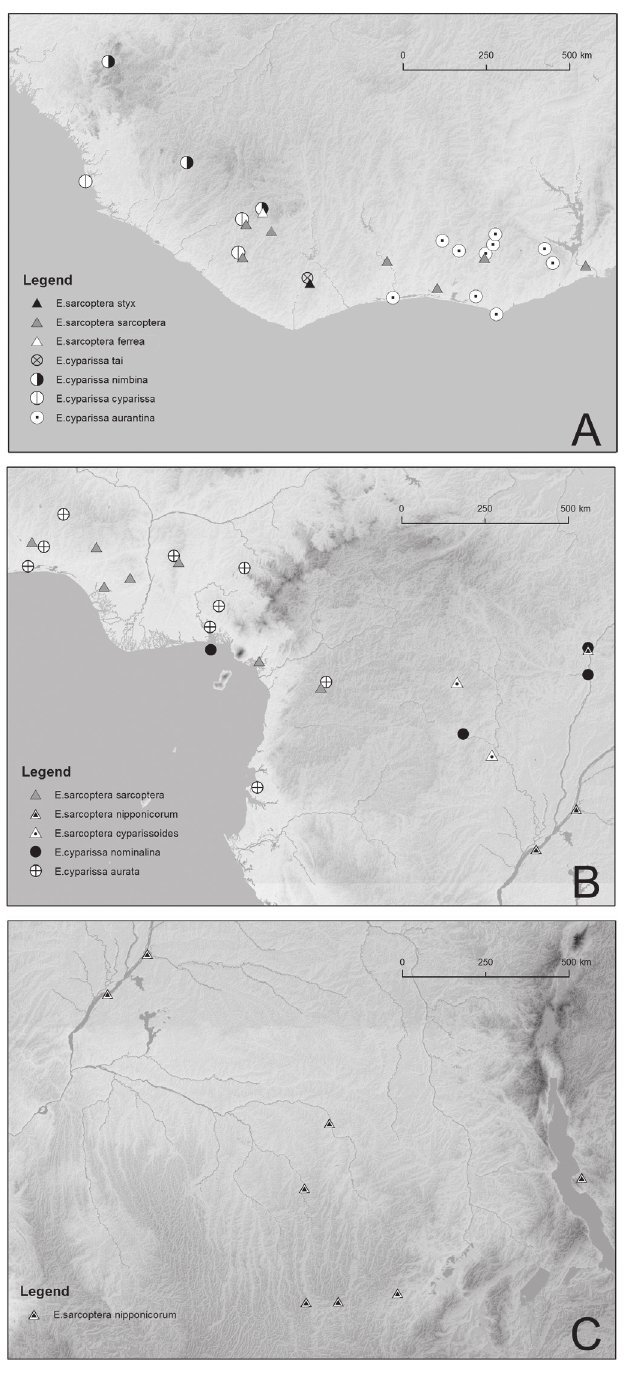
Figure 13. Distribution map: A West Africa, west of the Dahomey Gap B West Africa east of the Dahomey Gap, and central Africa C Congo